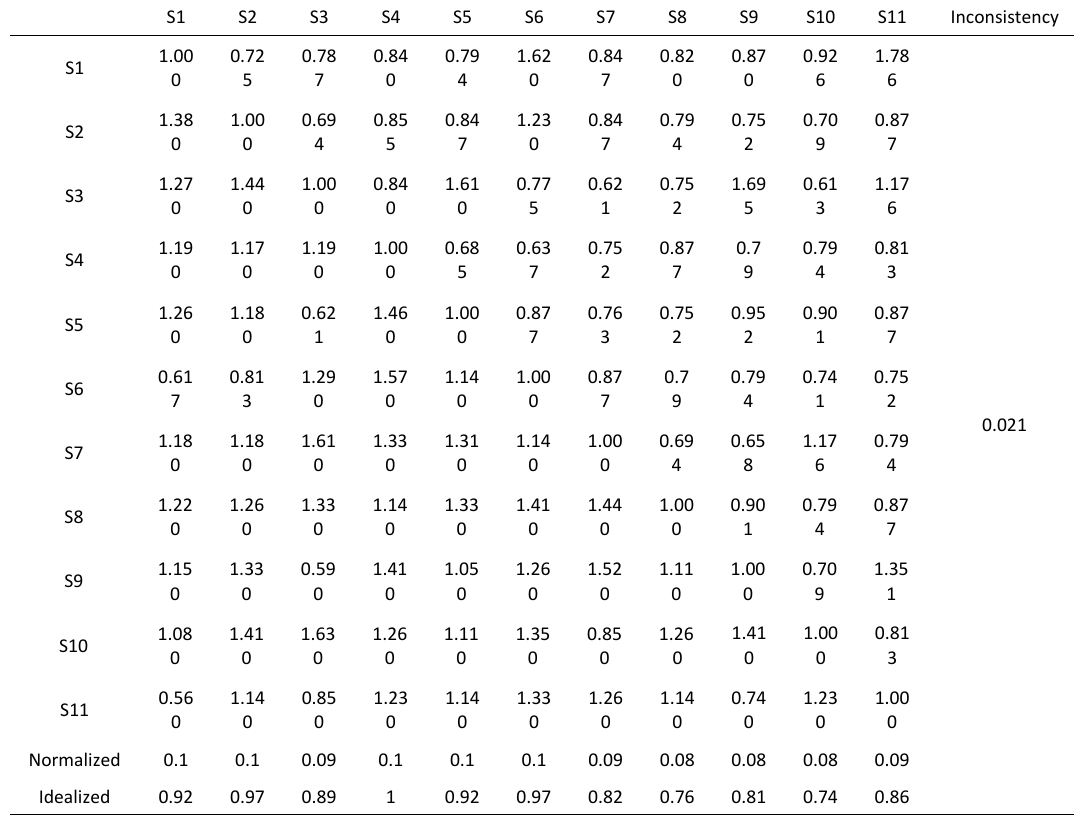
Table 6. Pairwise comparison matrix of technical